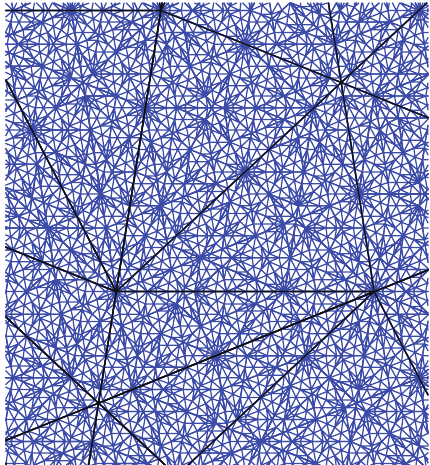
Figure 4: Level-3 supertiles in the ninefold symmetry